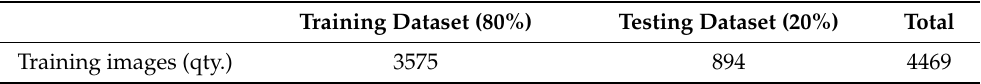
Table 3. Allocation of the training data.